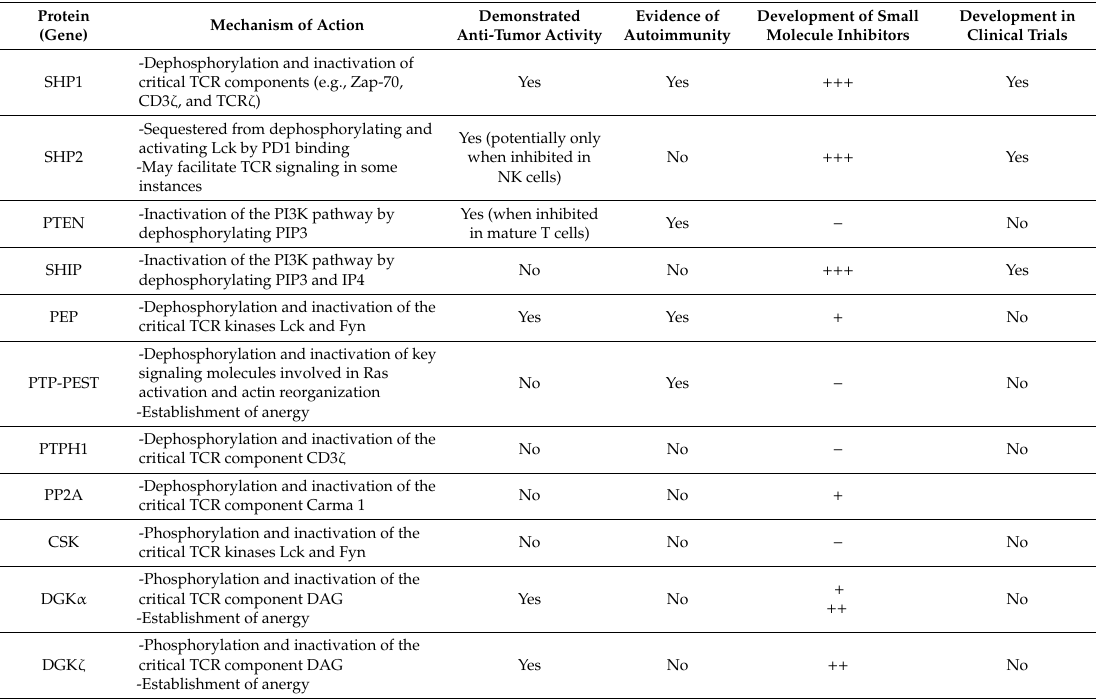
Table 2. Phosphatase / kinase intracellular